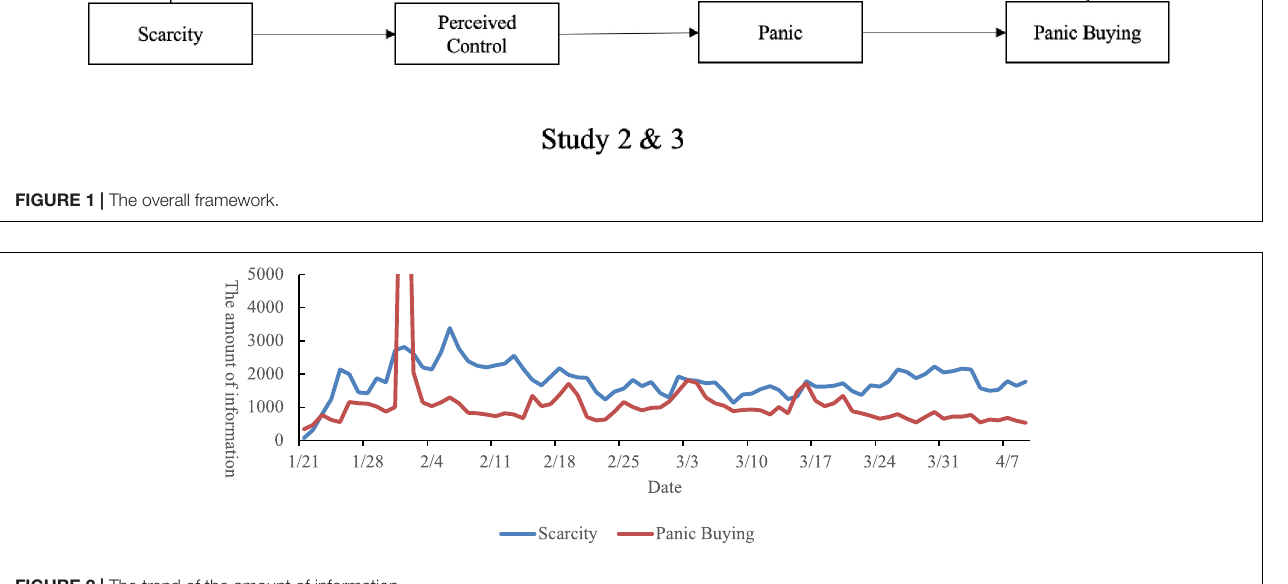
FIGURE 2 | The trend of the amount of